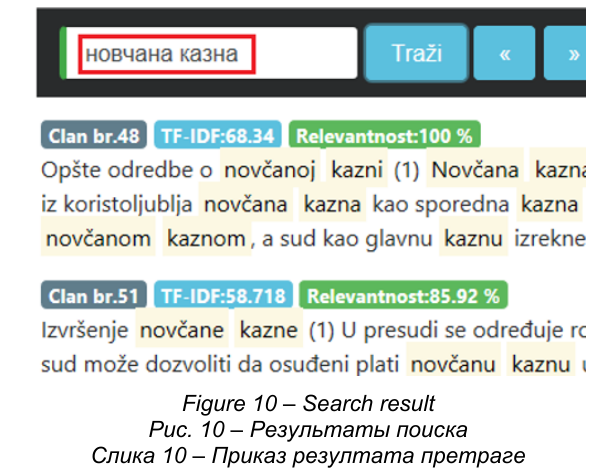
Figure 10 – Search result Рис . 10 – Результаты